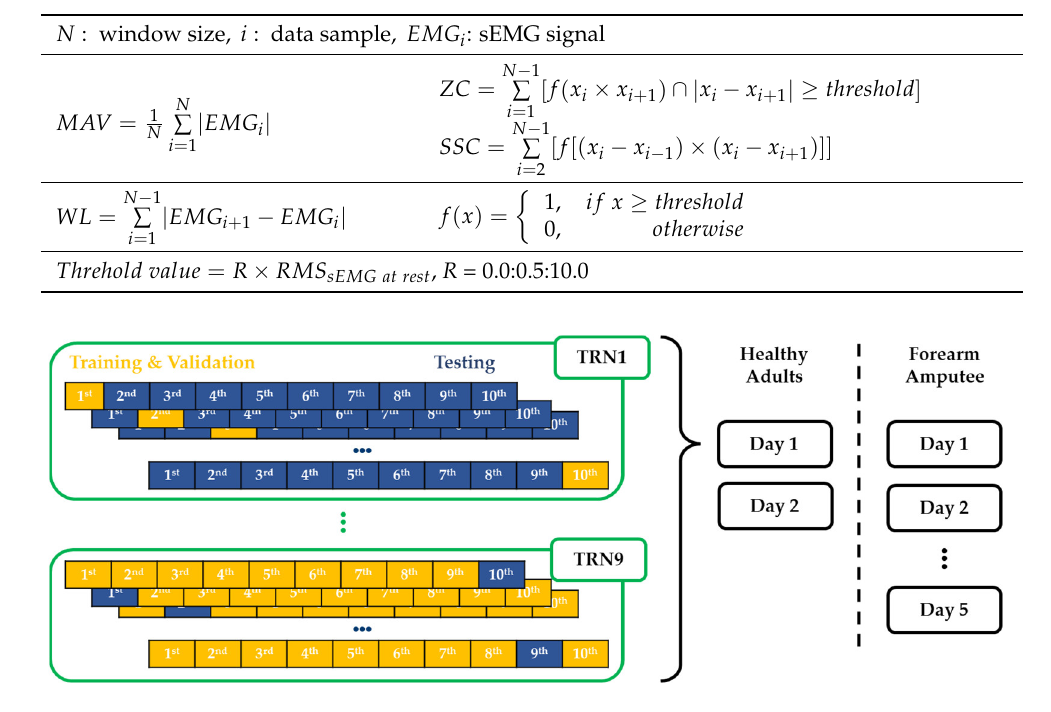
Table 1. Formulas for the feature vectors.